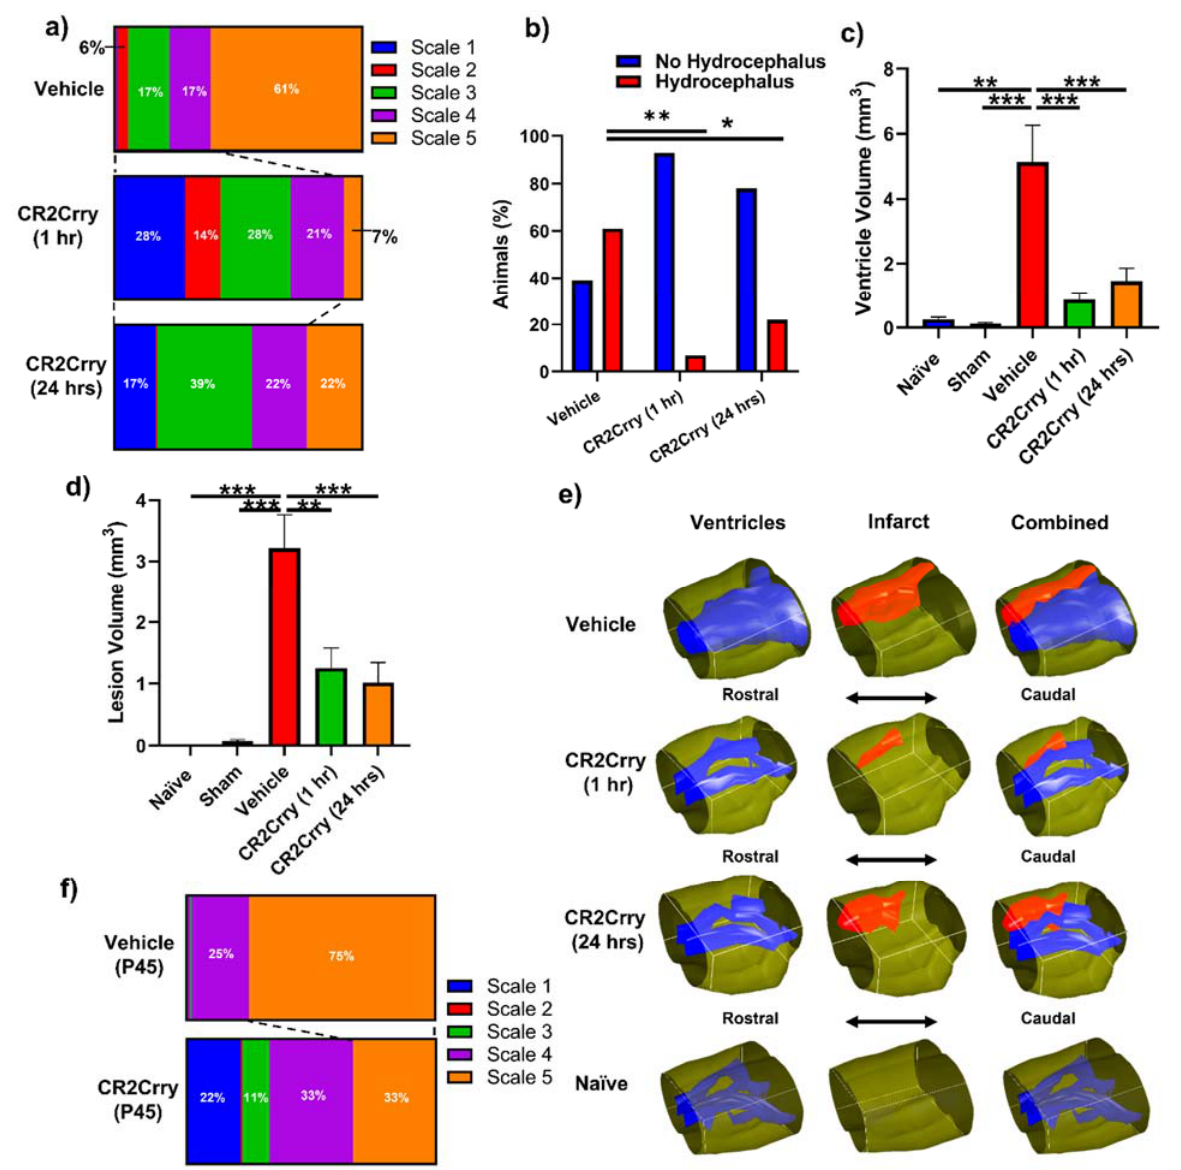
Figure 4. Complement inhibition leads to a reduction in lesion size and hydrocephalus. ( a ) Distri- bution of injury scales among the three different experimental groups: vehicle, CR2Crry (1 h), and CR2Crry (24 h). ( b ) Quantification of percent of animals that develop hydrocephalus (scale 5) vs. no hydrocephalus in vehicle, CR2Crry (1 h), CR2Crry (24 h). Chi-squared test performed between each hydrocephalus group. * p < 0.05, ** p < 0.001. ( c , d ) Lesion volume and ventricular volume quantification for the different groups together with naïve wild type and sham. One-way ANOVA with Bonferroni’s correction for multiple comparisons. ** p < 0.01, *** p < 0.001. n = 5 for Naïve, n = 7 for sham, n = 17 for vehicle, n = 14 for CR2Crry (1 h), and n = 17 for CR2Crry (24 h). Error bars = mean ± SEM. ( e ) Representative images with 3D reconstruction of ventricle and lesion volumes. No data points were excluded from the analysis. ( f ) Distribution of injury scales among the P45 vehicle and CR2Crry-treated groups. PHH was lower in the CR2Crry group ( p < 0.05).